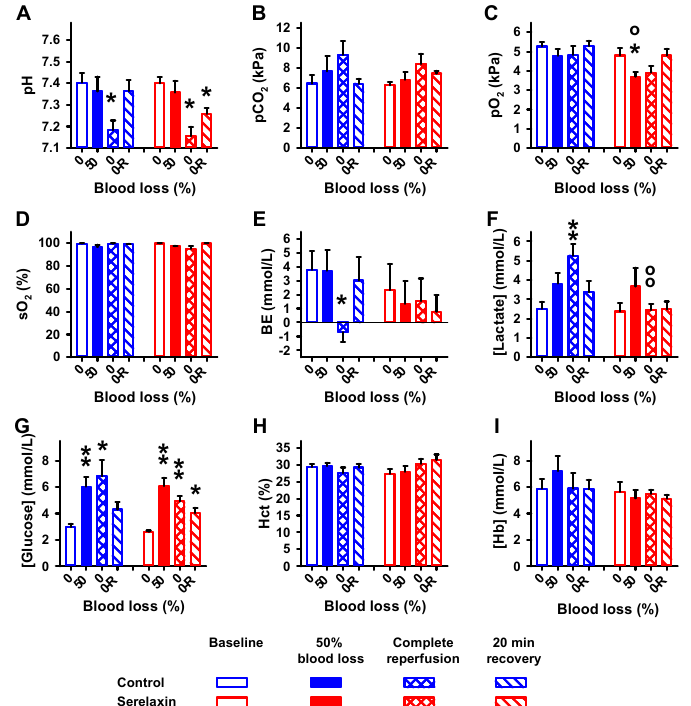
Figure 2. Effects of blood loss and reperfusion on blood parameters. Values are given for baseline, removal of 50% blood, complete reperfusion, and 20 min after the complete reperfusion in controls and the serelaxin-treated group. ( A ) pH, ( B ) pCO 2 , ( C ) pO 2 , ( D ) sO 2 , ( E ) BE, ( F ) lactate, ( G ) glucose, ( H ) hematocrit (Hct), and ( I ) hemoglobin (Hb). Mean ± SEM; * p < 0.05, ** p < 0.005 compared to baseline; o, p < 0.05; oo, p < 0.005 compared to controls.